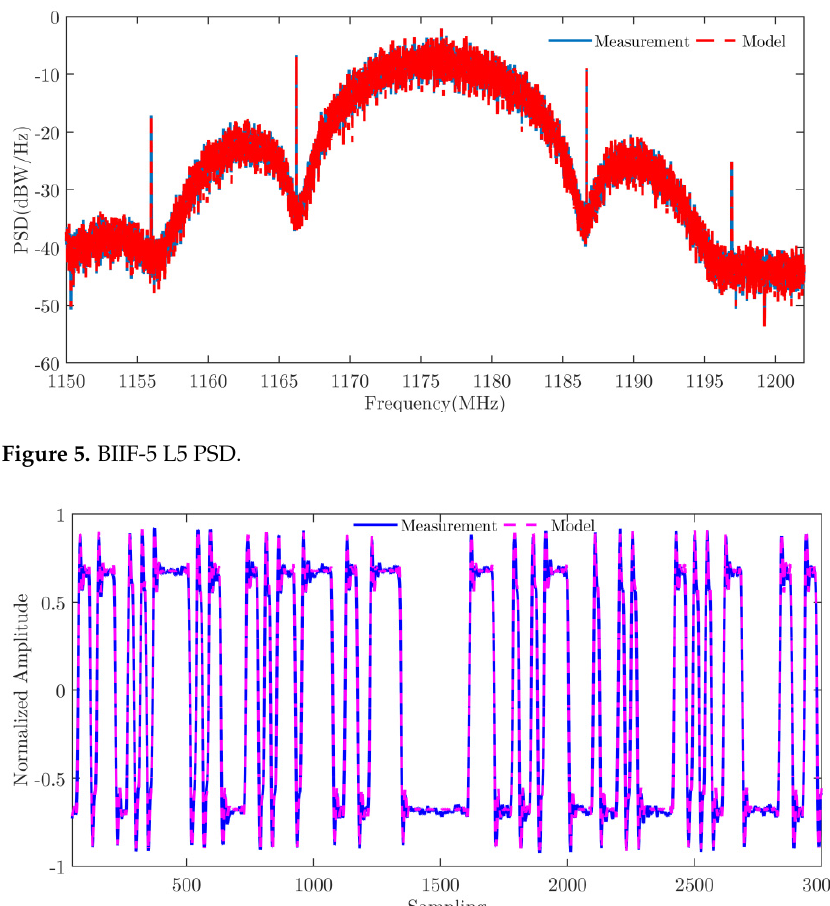
Figure 4. BIIF-5 L5-Cd time-domain waveform.